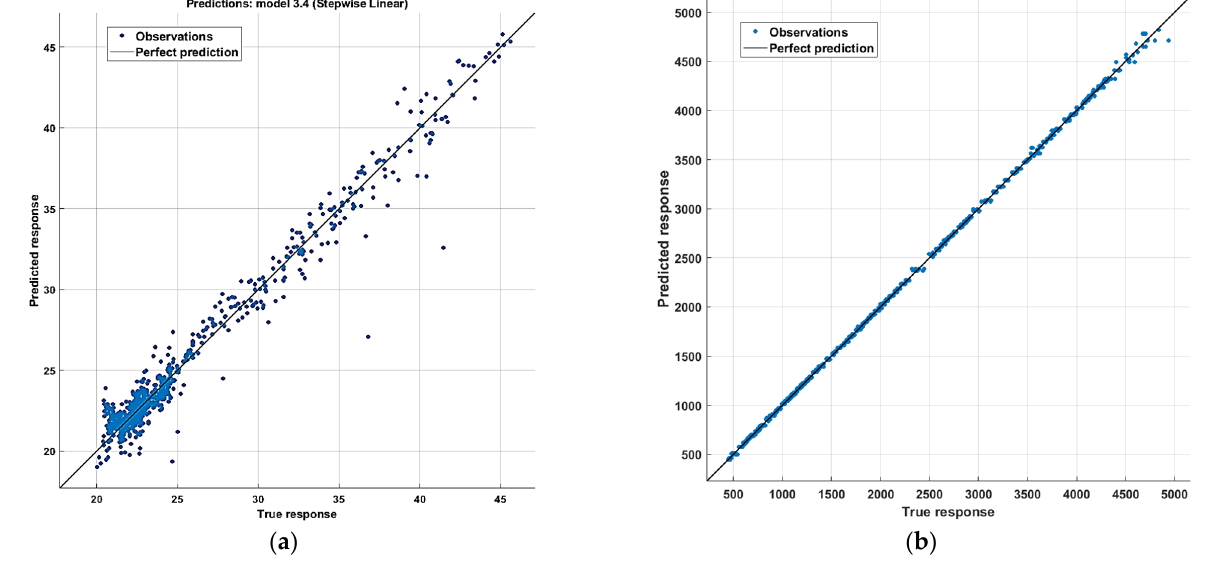
Figure 10. The SeReNo V2 Deployment in QU to utilize the GAM: ( a ) The Greenhouse Site Step-wise Linear prediction and ( b ) The Bi-cluster data-fusion at the central site.